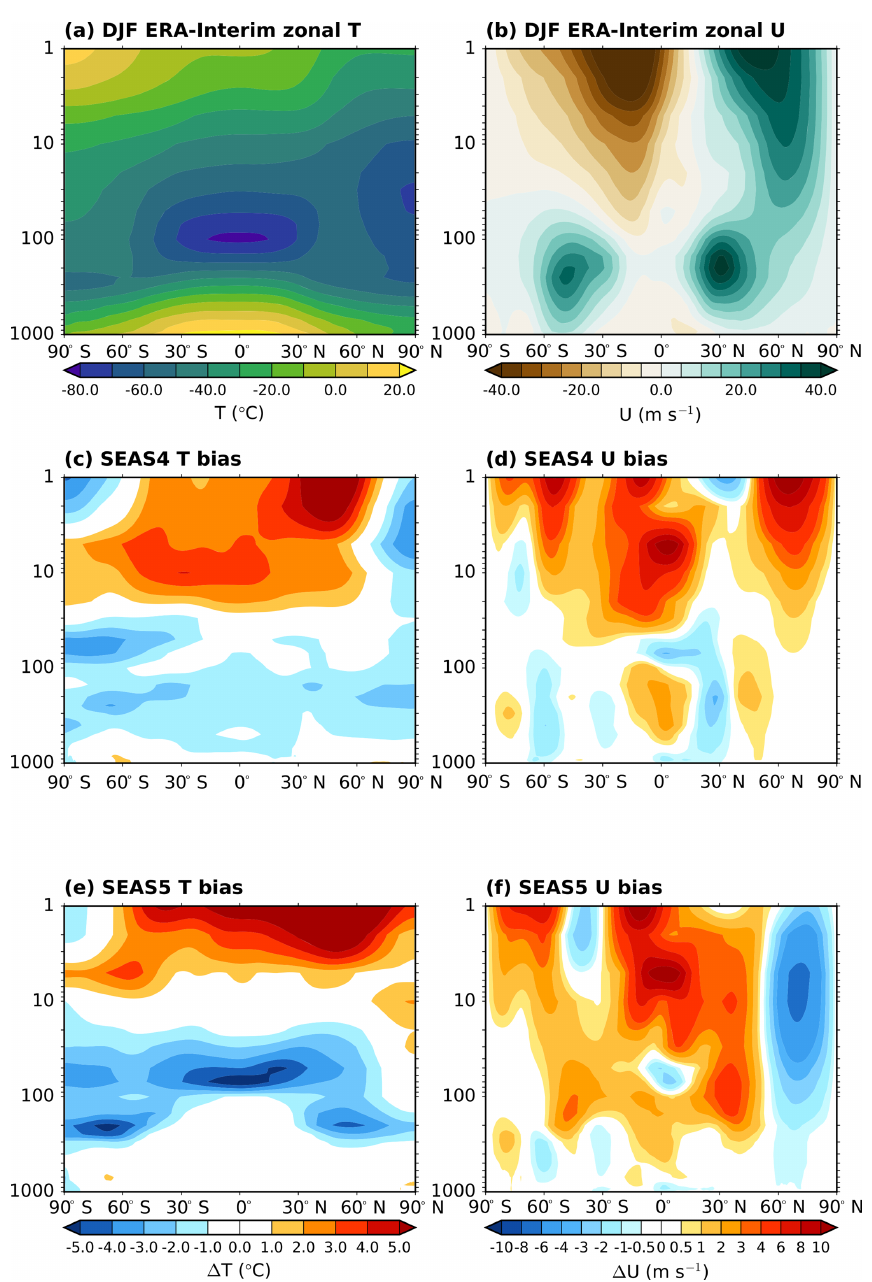
Figure 17. Zonally averaged profiles of ERA-Interim DJF zonal temperature (a) and wind (b) , as well as biases in SEAS4 (c, d) and SEAS5 (e, f) at 1 month forecast